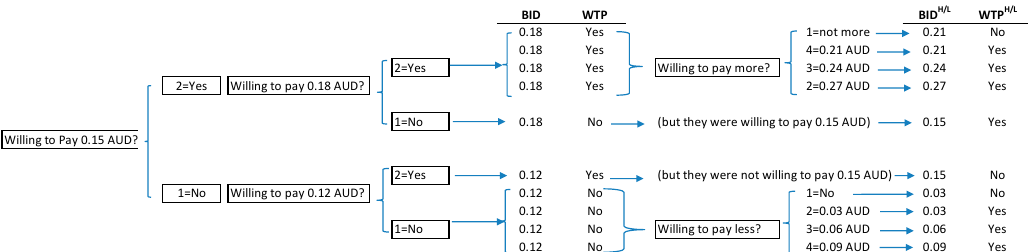
Figure 2. Questioning sequence and double-bounded dichotomous choice contingent valuation model setting. BID, bid (the hypothetical additional amount proposed for the Health Star Rating); WTP, willingness to pay; AUD, Australian dollars.